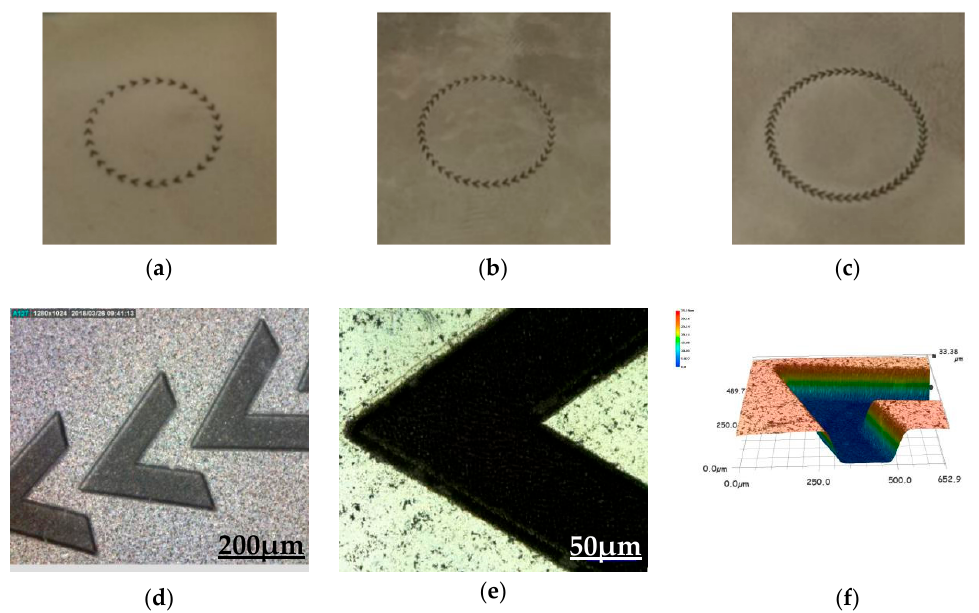
Figure 2. Triangular groove micro-texture arrays obtained by laser processing and micro-morphology of triangular groove taken by DINO-LITE microscope and ultra-high accuracy microscope. ( a ) Triangular groove texture with an area occupancy ratio of 7%; ( b ) Triangular groove texture with an area occupancy ratio of 10%; ( c ) Triangular groove texture with an area occupancy ratio of 13%; ( d ) Triangular groove texture microscopic morphology with a scale of 200 µ m; ( e ) Triangular groove texture microscopic morphology with a scale of 50 µ m; ( f ) Triangular groove texture 3D morphology.